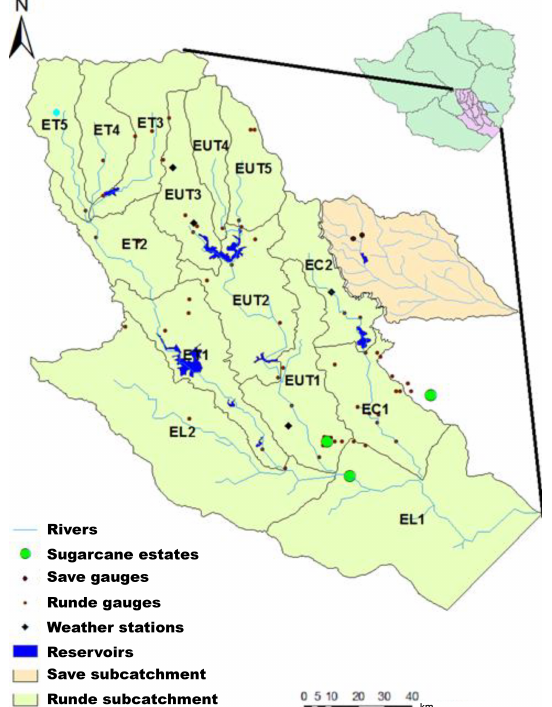
Figure 2. Methodology General Flow